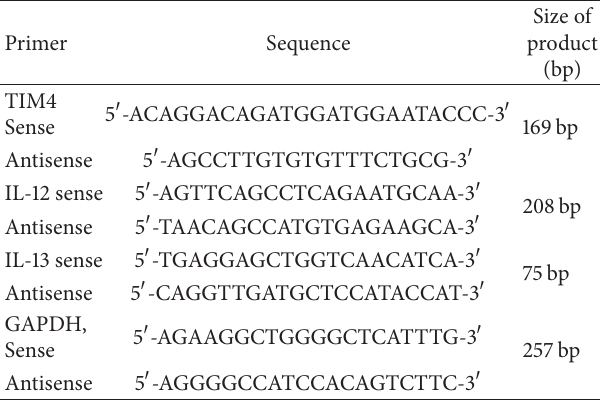
Table 1: Primer sequences used in quantitative real-time